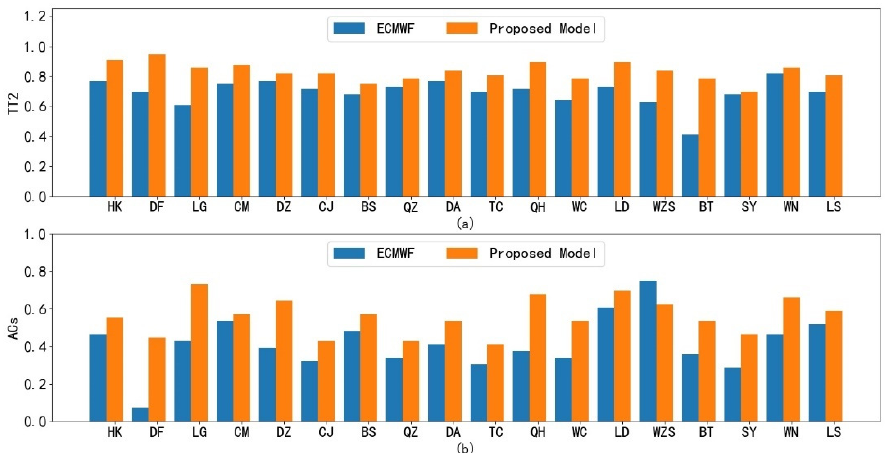
Figure 7. The comparisons of the ECWMF model and the proposed method at 18 cities: ( a ) average TT 2 index of temperature forecast for ECWMF prediction and proposed correction; ( b ) AC s index of wind speed for ECWMF prediction and proposed correction.